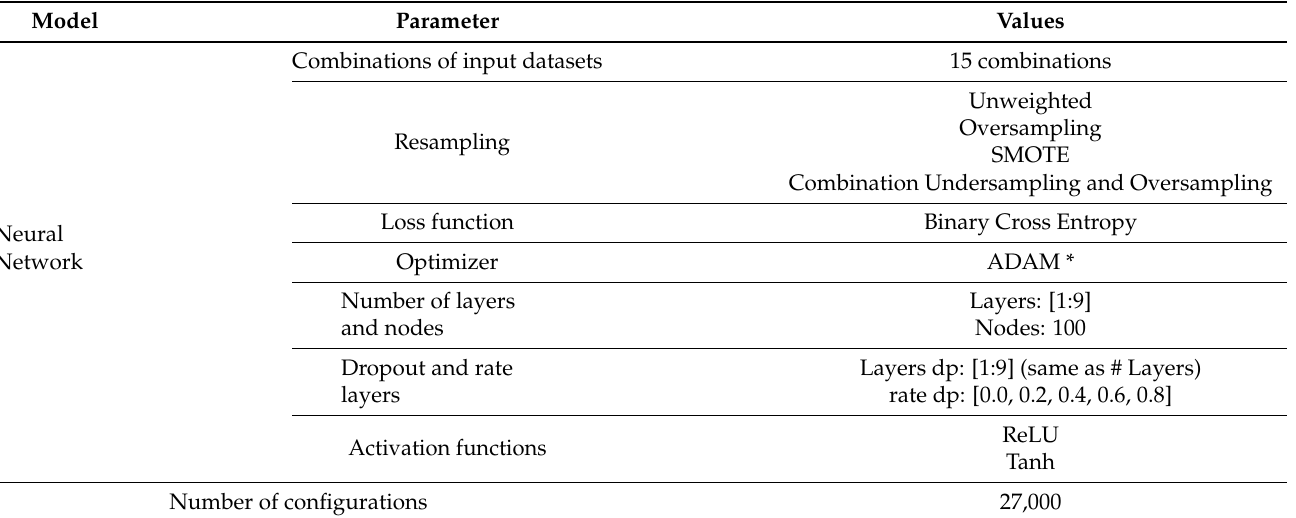
Table 6. Explored configuration